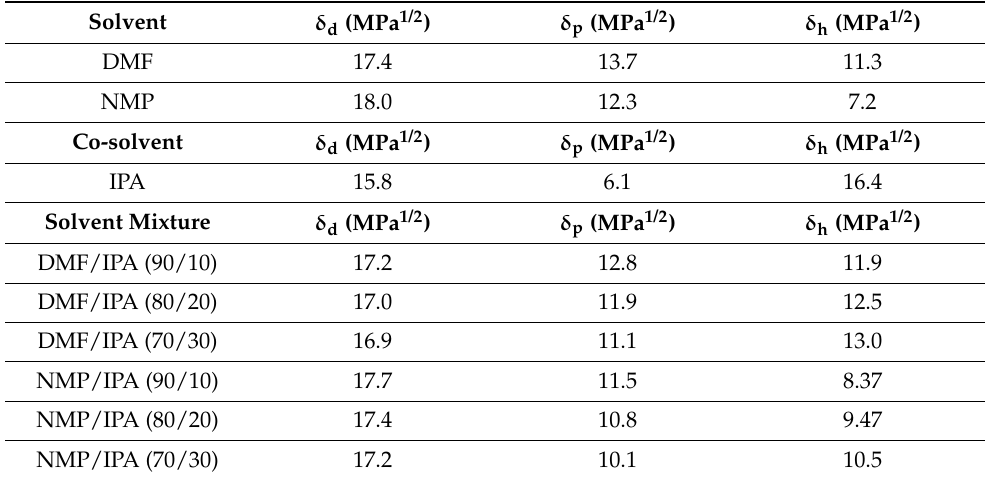
Table 3. Hansen Solubility Parameters of pure solvents and their binary mixtures with co-solvent investigated in this study